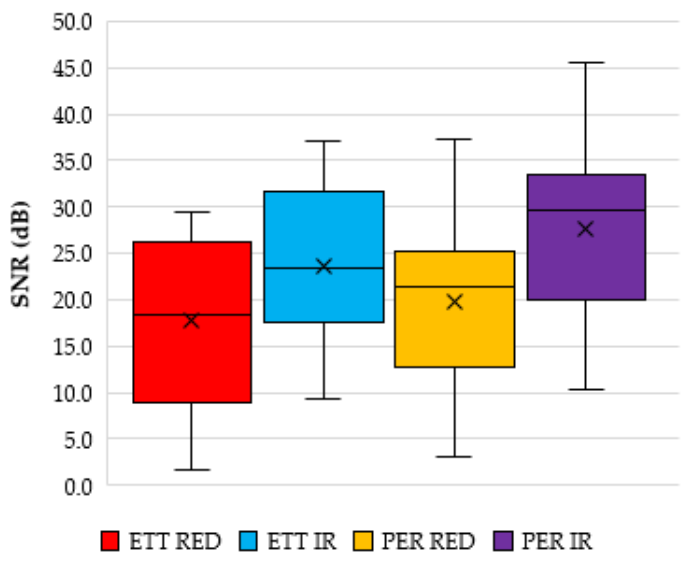
Figure 7. Signal to noise ratio analysis of the PPG signals from the ET and periphery (PER) sensors.